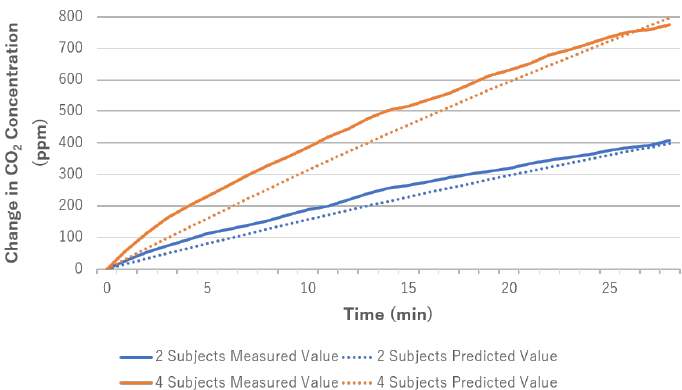
Figure 13. Predicted and measured values of CO 2 concentration in the small studio (2 and 4 subjects).